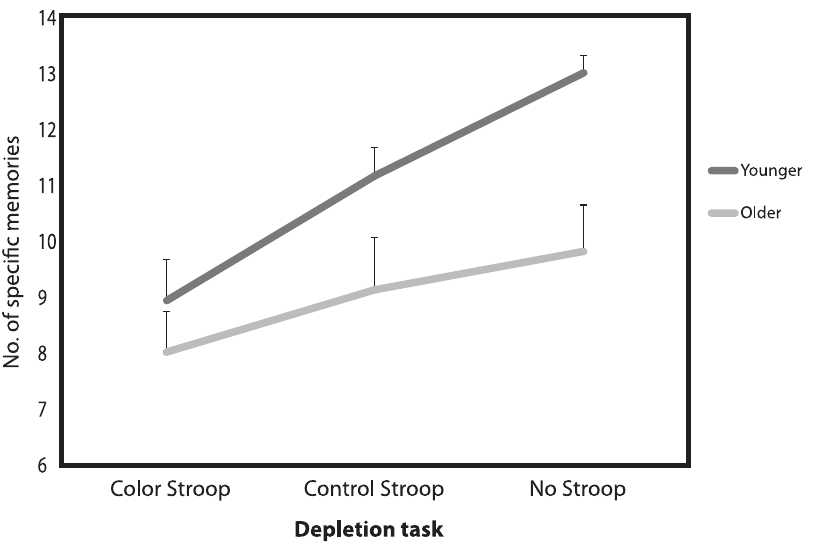
Figure 1. Autobiographical Memory Test performance across conditions. Mean ( + 1 SE ) total numbers of specific memories across the Color Stroop, Control Stroop and No Stroop conditions on the Autobiographical Memory Test for the Younger and Older age groups. doi:10.1371/journal.pone.0026351.g001 PLoS ONE |